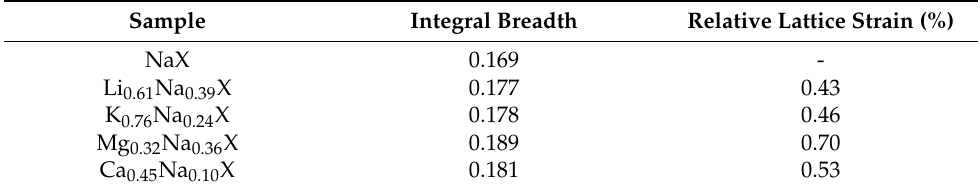
Table 4. Integral breadth and calculated strains from the Wilson formula